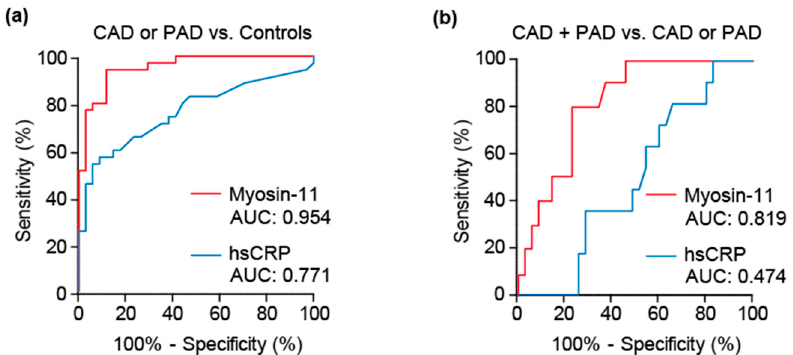
Figure 3. ROC (receiver-operating characteristic) analysis of myosin-11 (myosin heavy chain 11) and hsCRP (high-sensitivity C-reactive protein). ( a ) ROC curves of myosin-11 and hsCRP in patients with CAD (coronary artery disease) or PAD (peripheral artery disease) and control subjects. ( b ) Receiver-operating characteristic curves of myosin-11 and hsCRP in patients with CAD + PAD and CAD or PAD. AUC: the area under the curve.